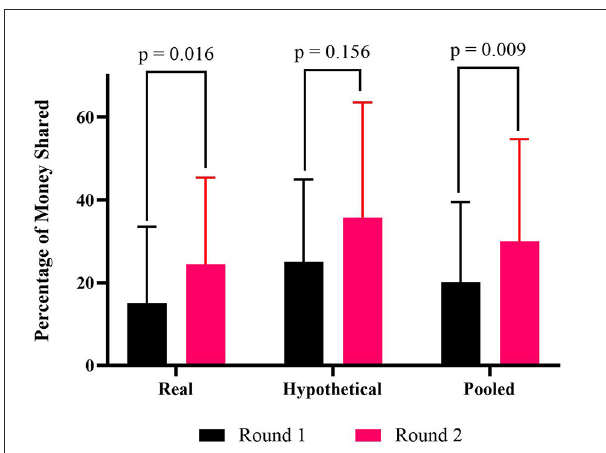
FIGURE4 The Dictator Game money distribution. The mean and standard deviation of the percentage of money shared with the Telenoid across two rounds where the vertical axis represents the percentage of the total amount of money shared. Round 1 is the first game played by the participant after hearing the introductory speech from the Telenoid. Round 2 is the second game played by the participant after having an interactive conversation with the Telenoid. The leftmost columns represent the participants that played the game with real incentives, while the middle columns represent the participants that played the game with hypothetical incentives. The rightmost column represents all the participants from the hypothetical and real incentive.